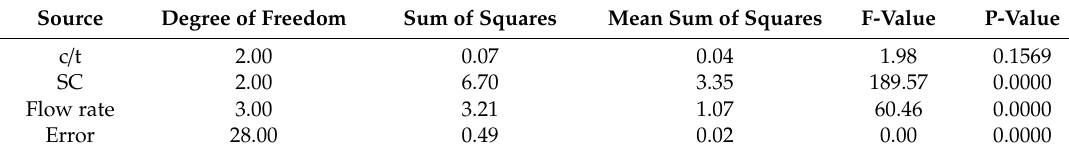
Table 2. Analysis of variance (ANOVA) values of pipeline resistance